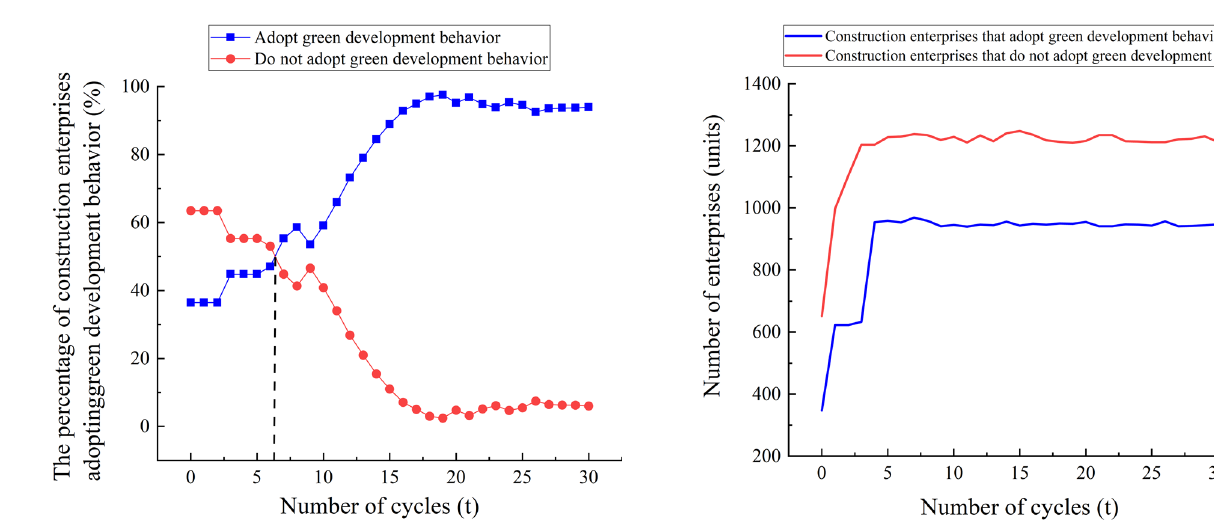
Fig. 6 The process of the in fl uence of unsustainable environmental regulations on the scale of the green development behaviors adopted by construction enterprises. The illustration shows the growth over time of the number of construction enterprises that adopt green development behaviors and those who do not adopt green development behaviors in the “ world ” under the in fl uence of unsustainable environmental